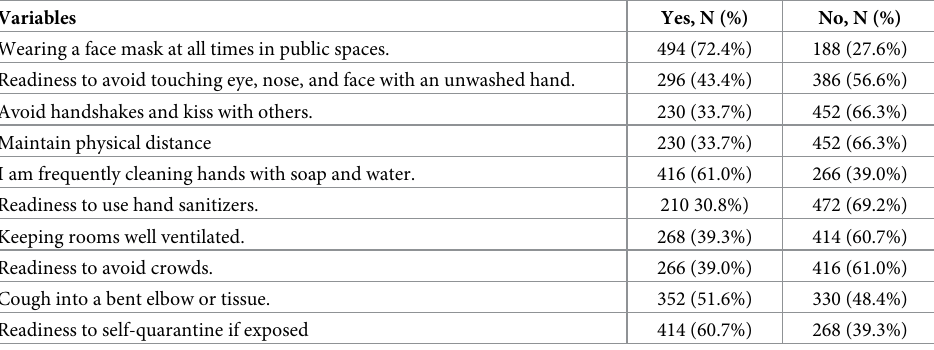
Table 4. Preparedness of students to combat the spread of COVID-19 pandemics in DBU, 2020. Variables Yes, N (%) No, N (%) Wearing a face mask at all times in public spaces.